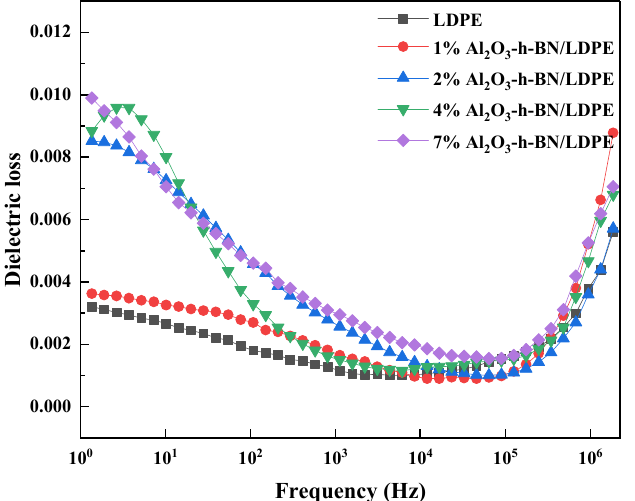
Figure 5. Dielectric loss of LDPE and Al 2 O 3 -h-BN/LDPE composite specimens as a function of